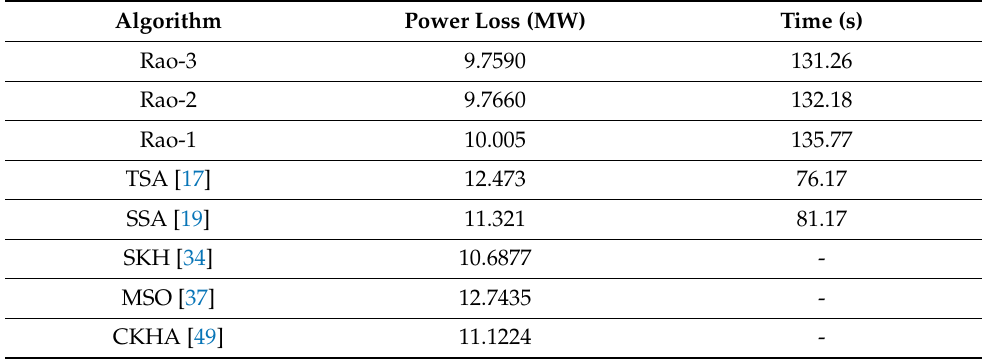
Table 16. Case 10: RPLM results in the IEEE 57-bus system.